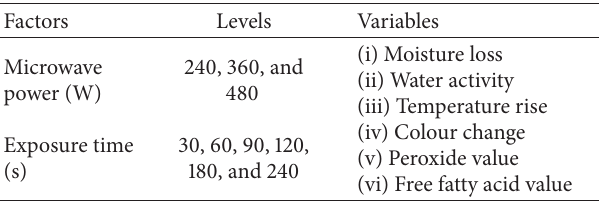
Table 1: Experimental details (process parameters and their